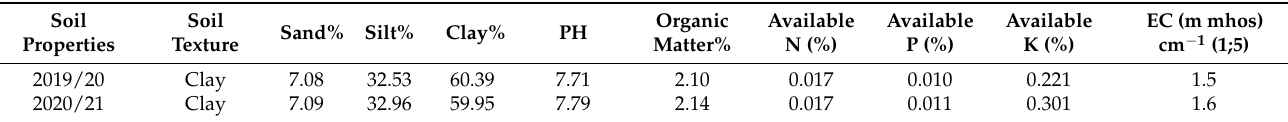
Table 1. The physical and chemical analysis of experimental soil before sowing of preceding crops during 2020 and 2021 seasons.